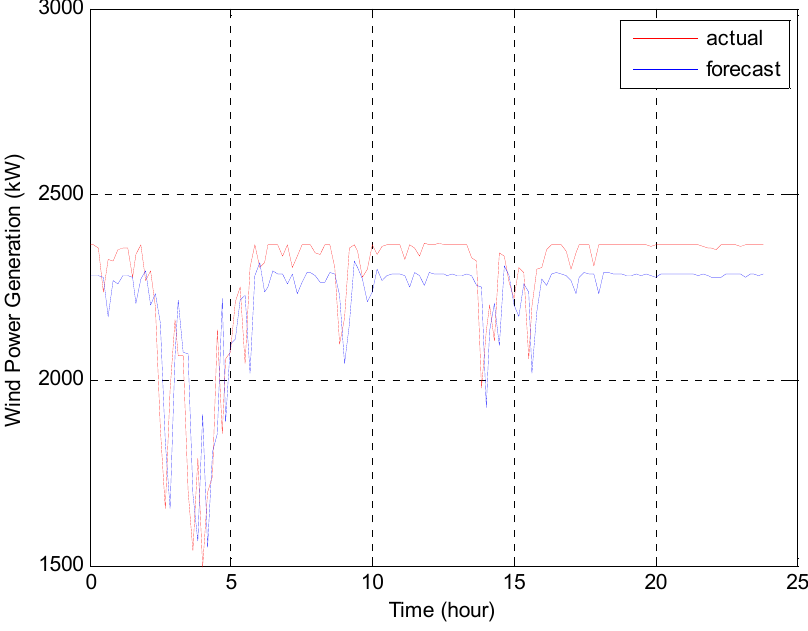
Figure 6. Numerical results with the back propagation neural network method for typical winter day.